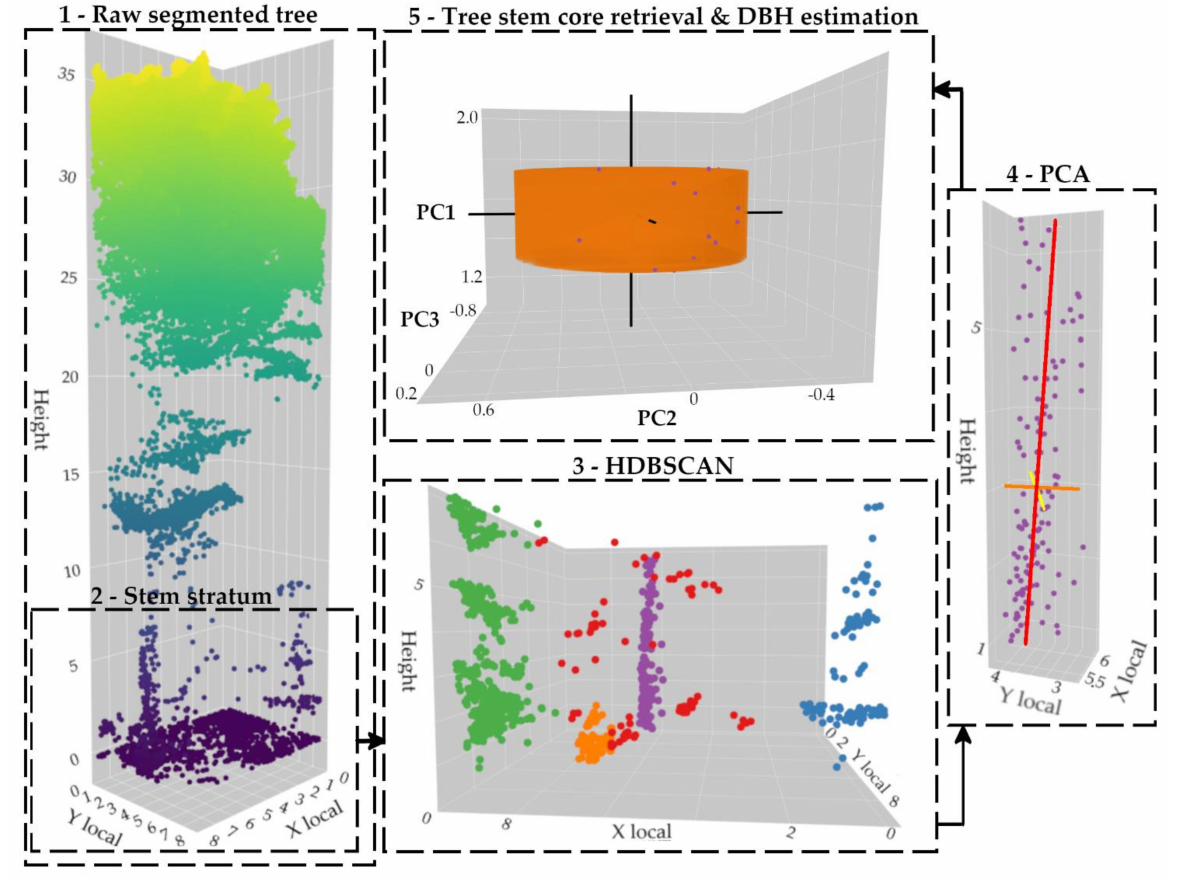
Figure 7. Tree-level point cloud processing flow for segmenting and classifying the tree stem and estimating the DBH. HDBSCAN: Hierarchical Density-Based Spatial Clustering of Applications with Noise; PCA: Principal Components Analysis. The tree stem is modeled as a cylinder created from the DBH estimation with a height of 0.2